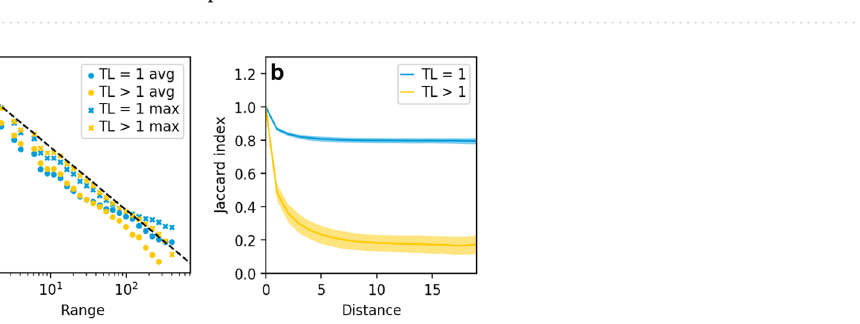
Figure 3. Patterns emerging in a square lattice of 1600 habitats for different dispersal rates d , note the logarithmic scaling of the axes. ( a ) Lifetime distributions are broad and close to a power law with exponent − 2.4 (black, dashed), considerably steeper than the slope of − 1.67 reported by 22 (grey dotted). ( b ) SAR reach empirically reasonable values (black dashed, slope of 0.36 9 ) for intermediate areas. For large areas curves bend toward a slope of 1 (grey, dotted). Dispersal rate decreases the slope of the SAR. ( c ) Average area (number of occupied habitats over the lifetime of a species) increases with lifetime. Larger dispersal rate shifts the curve to larger areas. Dashed line has a slope of 1.